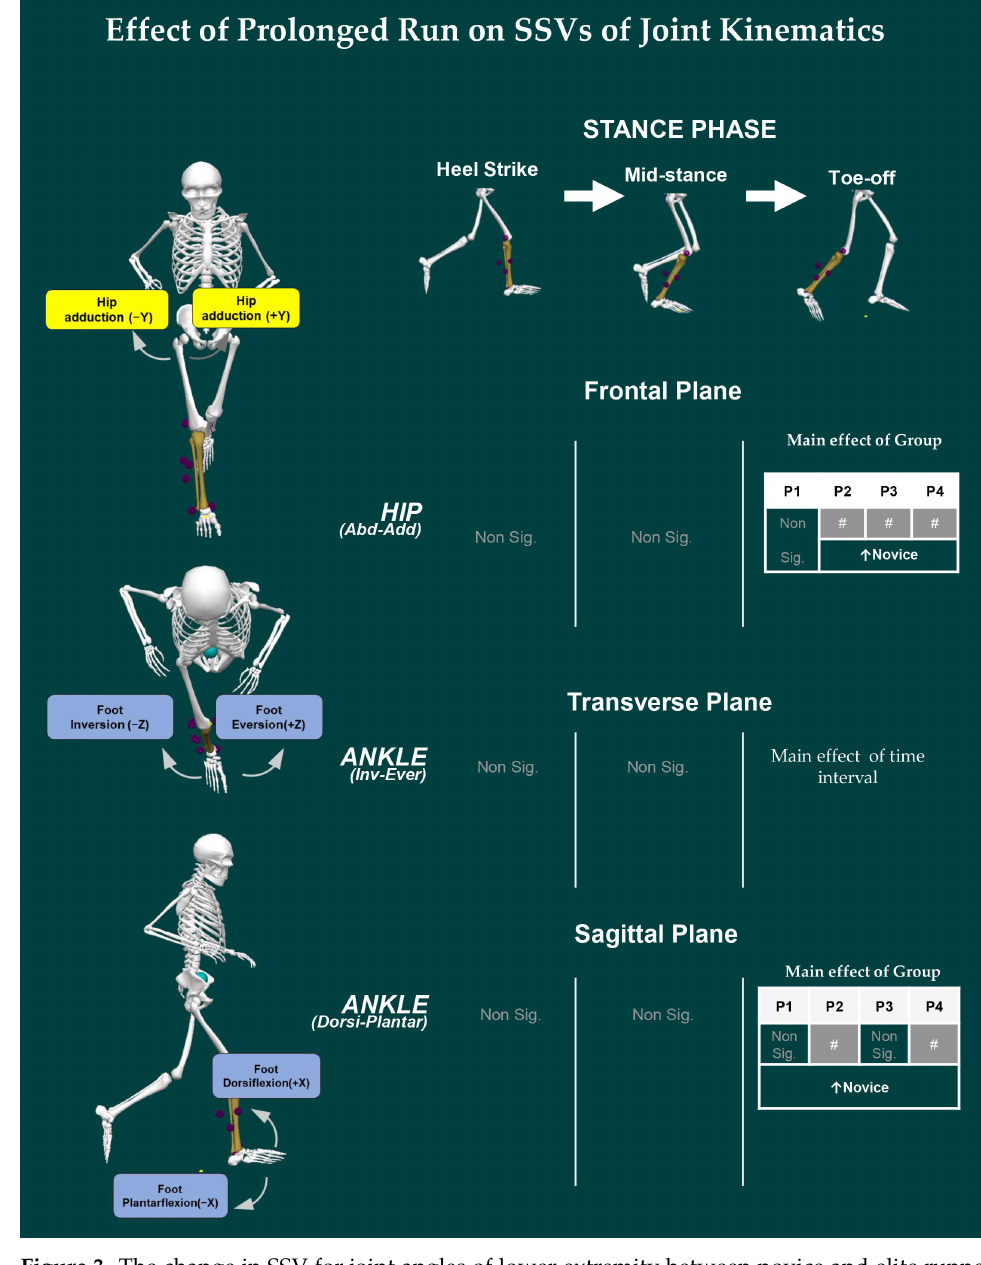
Figure 3. The change in SSV for joint angles of lower extremity between novice and elite runners throughout the prolonged run is presented here. Note: Only results with significant differences are labeled in the skeleton. “Stride-to-stride fluctuation” denoted as: “SSF” and “stride-to-stride variation” denoted as “SSV”. The main effect of Group and Interaction represented by “#”. The main effect of Time and Interaction for each time interval for each group, for example, the difference in time interval in P1 vs. P2 for novices is denoted as N1 vs. N2. Non-significant differences are represented by “Non sig.” For details, see Appendix B. The skeleton used for figure was created using Visual 3D